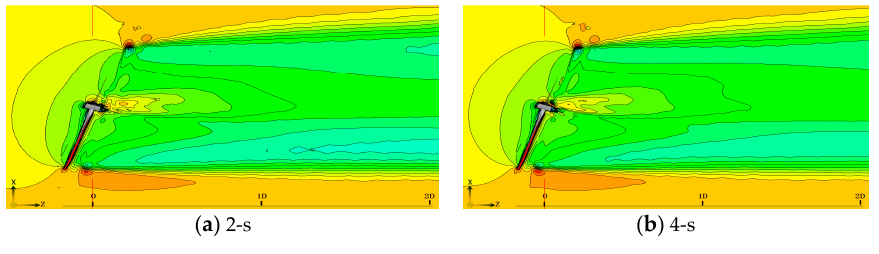
Figure 22. Velocity contours for Case 4.